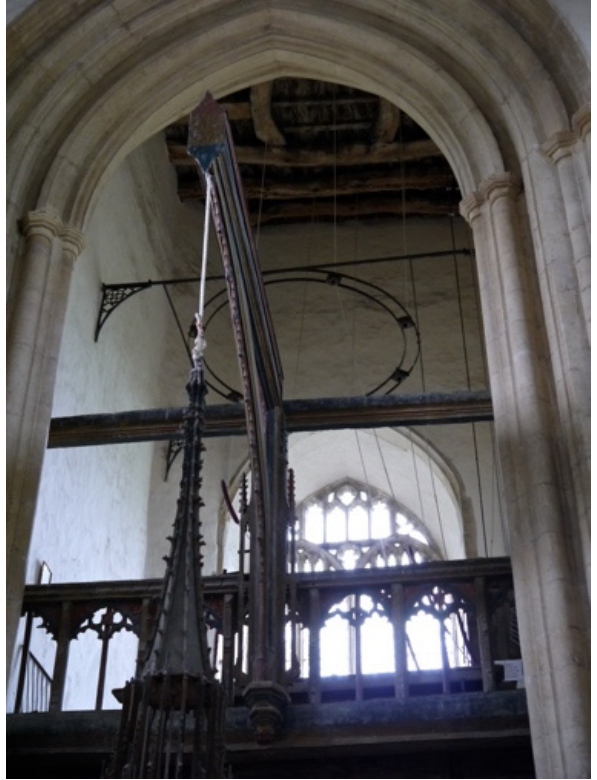
Figure 9. Font cover suspended from bracket attached to ringing gallery at Salle.